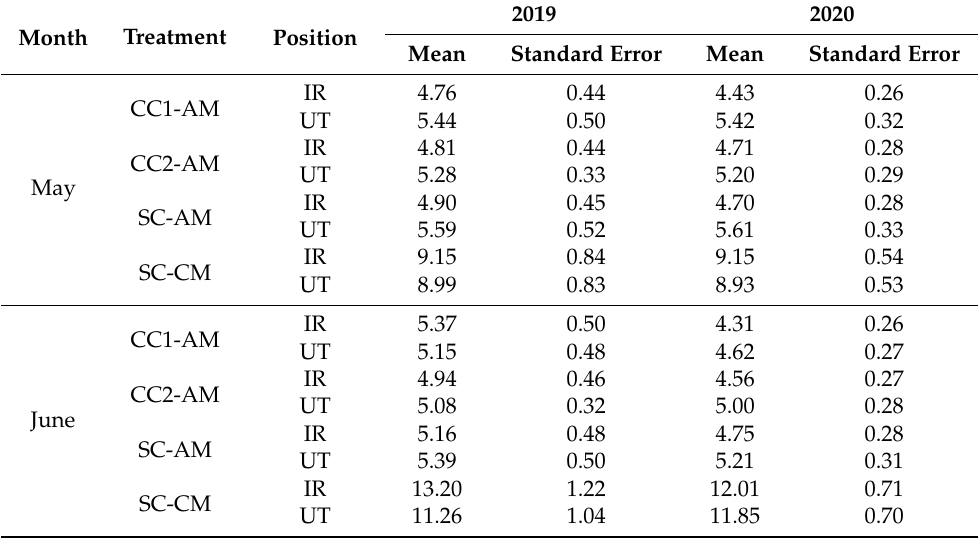
Table A6. Floor canopy height monthly trend during vines growing season (May–October)